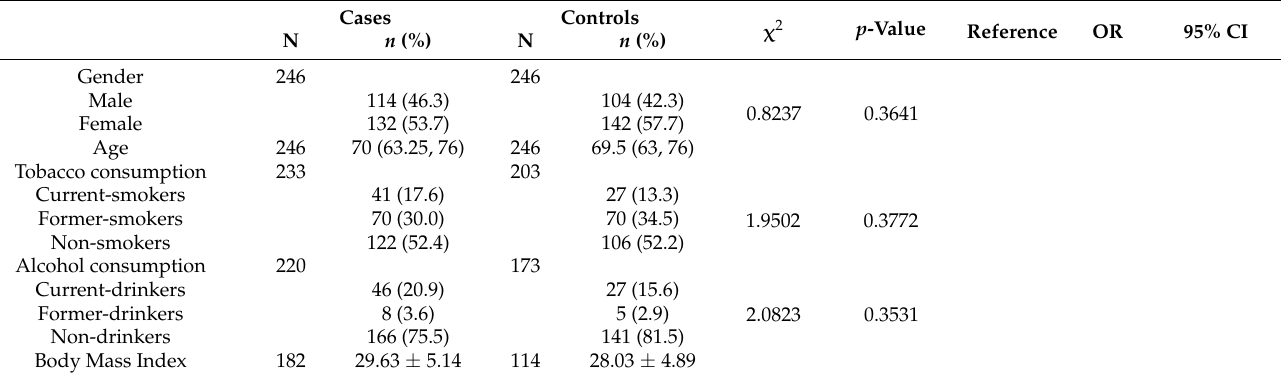
Table 1. Clinico-pathologic characteristics of cardiology cases and